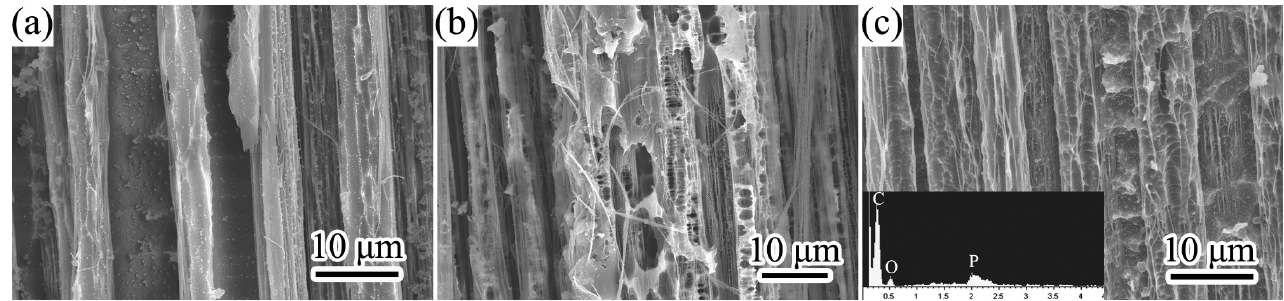
Figure 11. SEM images of mode II delamination surfaces after AO erosion of the ( a ) control, ( b ) PS0-C, ( c ) PS100-C.